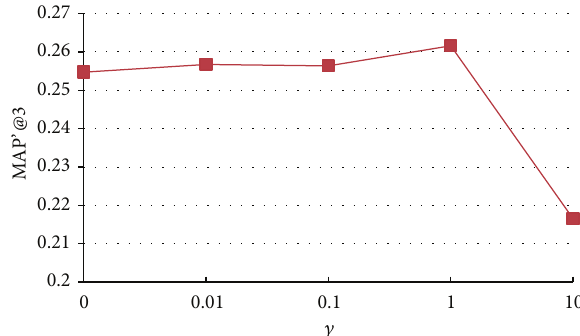
Figure 5: Impact of parameter 𝛾 on accuracy of Seeker source n model .